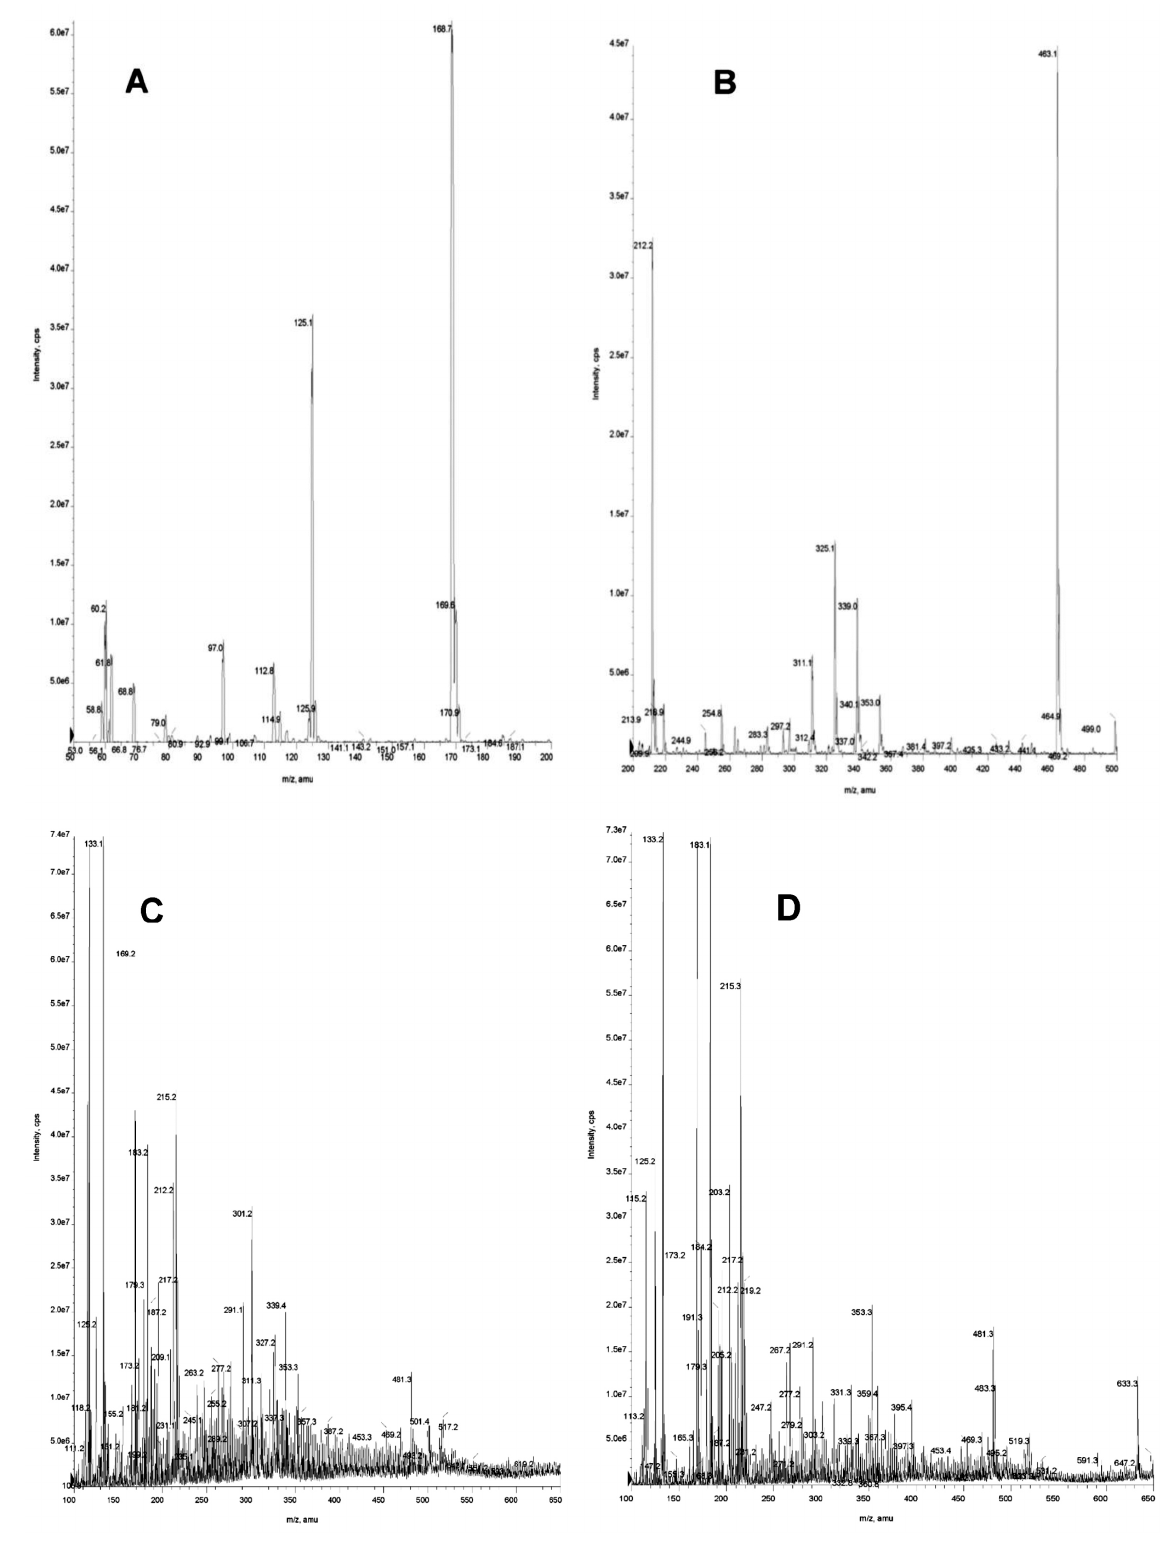
FIGURE 1 - Phenolic compounds found in the investigation by LC-MS/MS (A. Gallic acid analysis – target ion 169; B. Hyperoside analysis – target ion 463; C. ALE100 analysis, an example of an extract containing gallic acid; D. MLE analysis, the only extract that contained